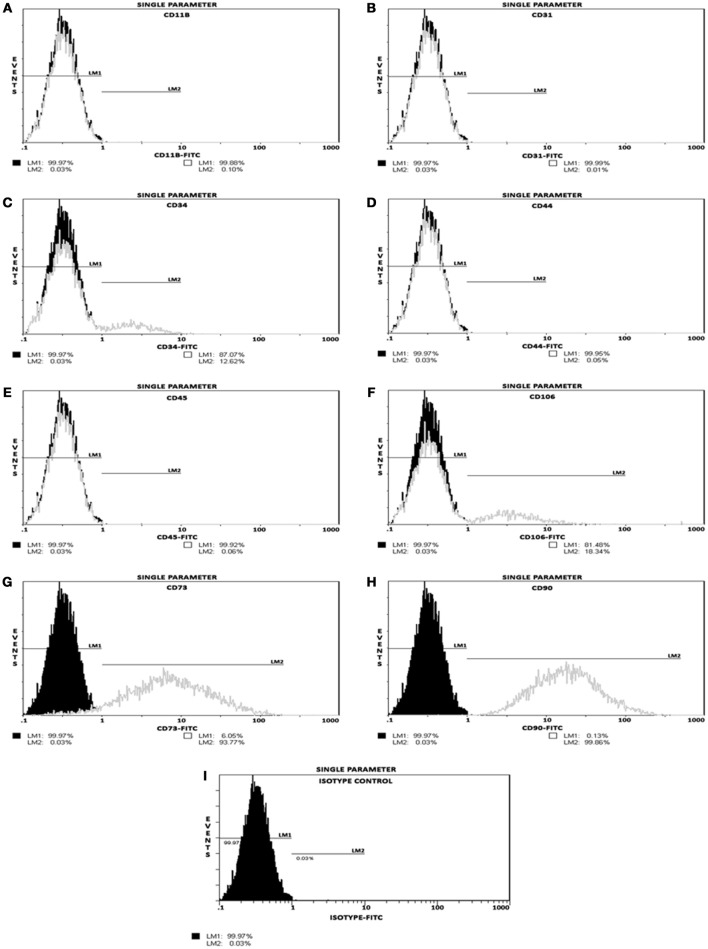
Postnatal MSCs surface marker expression. Analysis of positive and negative cell-surface antigen expression in a pool of expanded and passage 3 postnatal bone marrow-derived MSCs, by single color flow cytometry. (A–F) Histograms validating percentage expression of MSC-associated negative markers. The intensity and distribution of cells stained for endothelial and hematopoietic cell-surface antigens, such as CD11b, CD31, CD34, CD44, CD45, and CD106 (gray, open peaks) were not significantly different from those of isotype control (I; black, shaded peaks). (G,H) Histograms validating percentage expression of MSC-associated positive markers. The fluorescent intensity was greater (moved to right) when MSCs were stained with CD73 or CD90 surface antigens. These results indicated that these cultures contained a near-pure population of MSCs as defined by the minimal criteria for MSC surface antigen immunophenotyping.